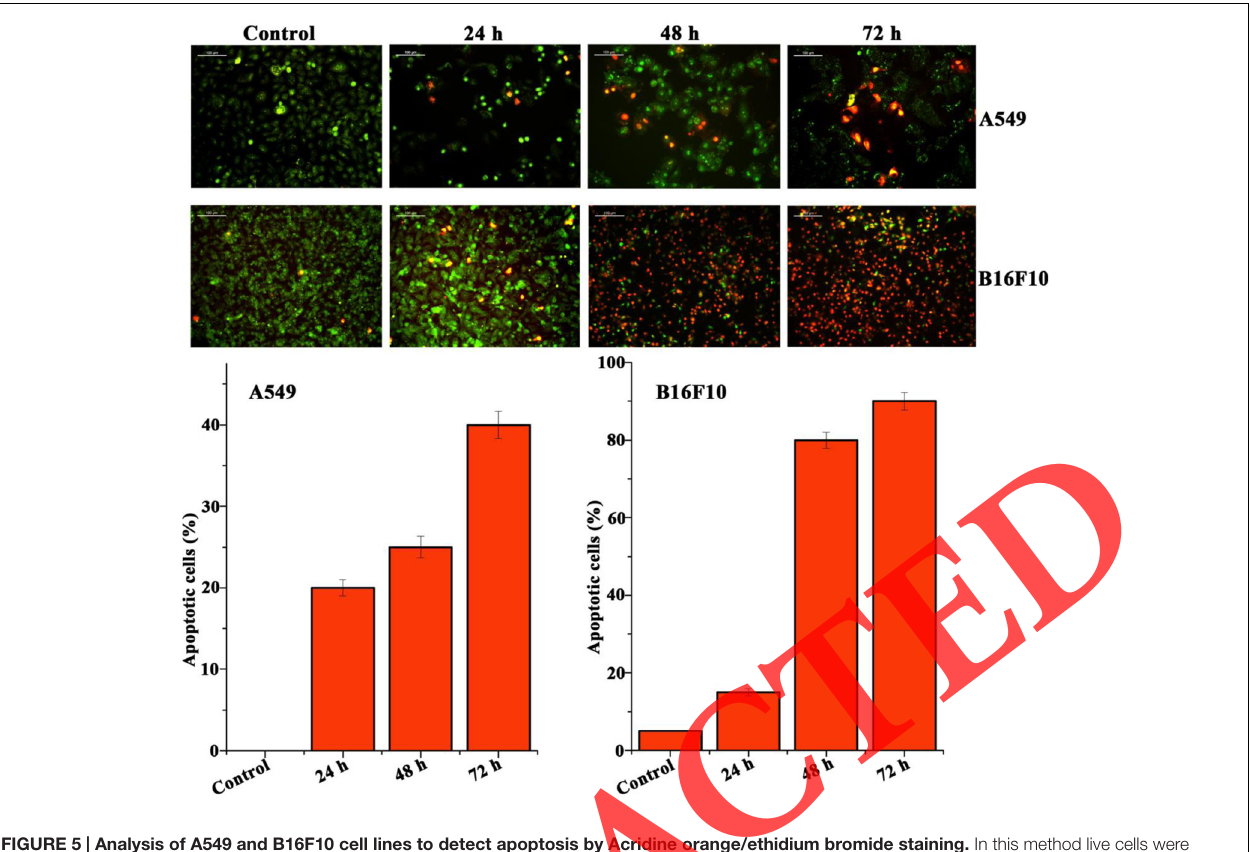
FIGURE 5 | Analysis of A549 and B16F10 cell lines to detect apoptosis by Acridine orange/ethidium bromide staining. In this method live cells were detected as green color, whereas the apoptosis cells documented orange-red due to the co-staining of acridine orange with ethidium bromide stain due to the loss of membrane integrity by the action of Pseudopyronine